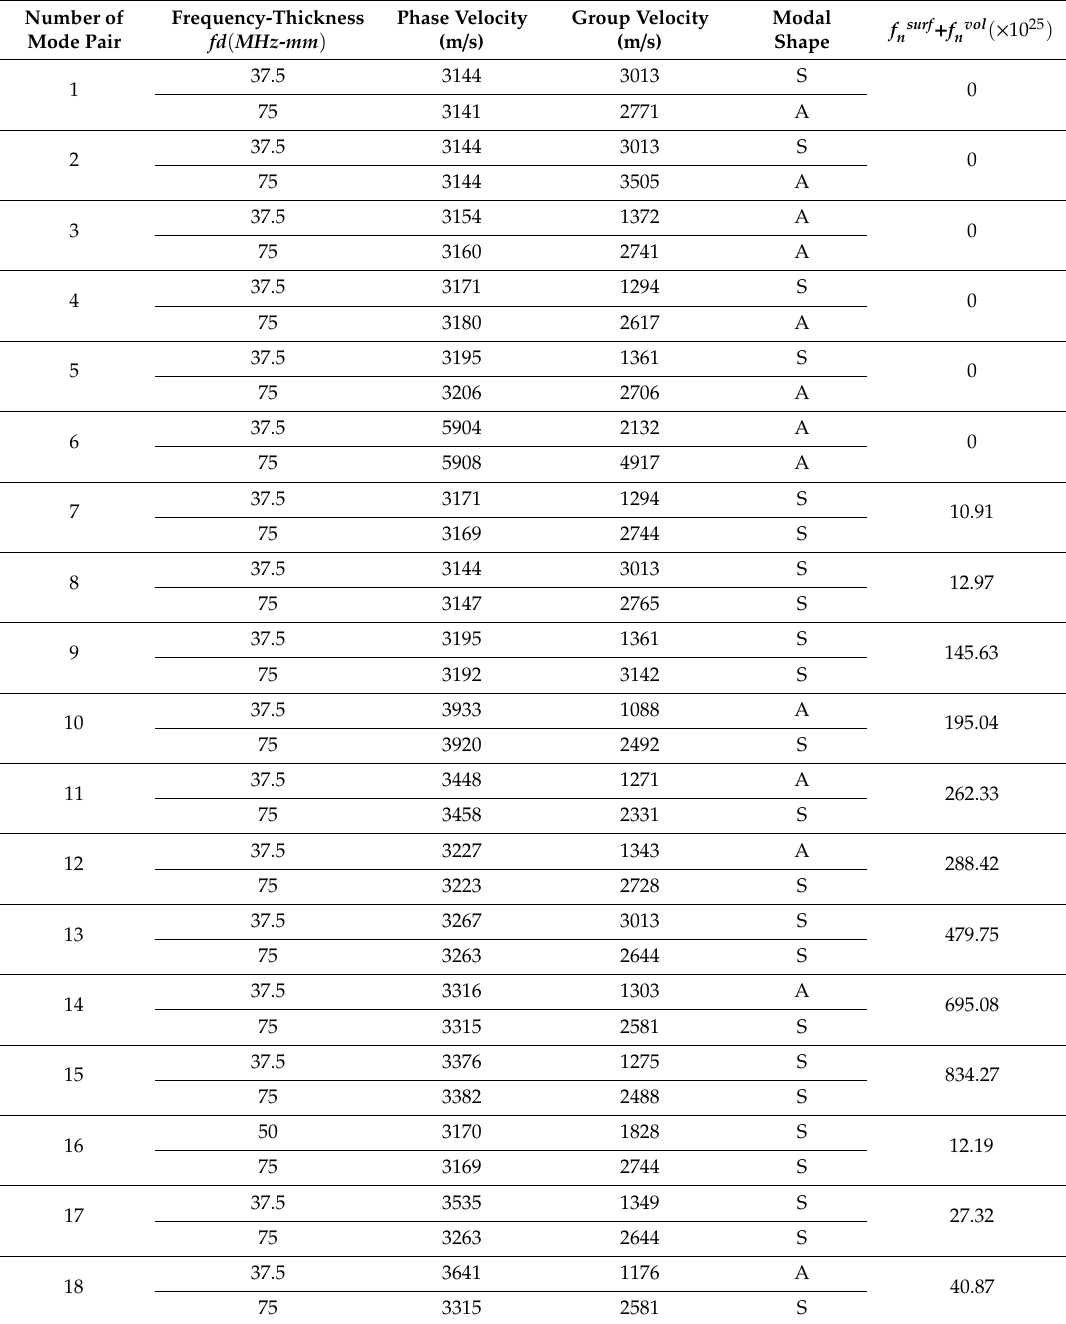
Table 2. Parameters of mode